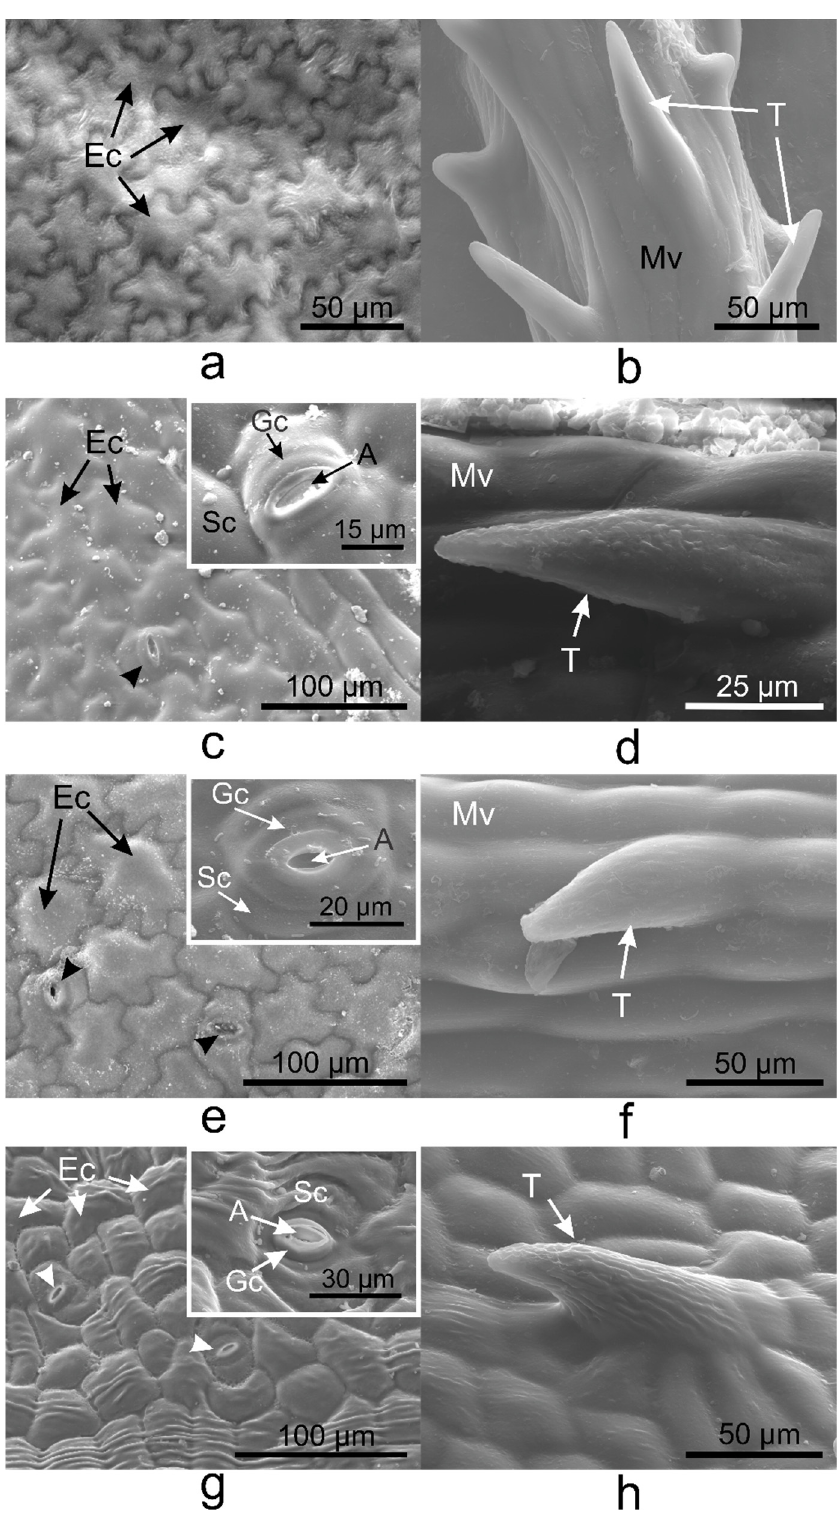
Figure 1. Scanning electron microscopy (SEM) micrographs showing the adaxial (upper) epidermis of the Vinca leaves with an overview of the differently shaped epidermal cells and insets with a detailed view of stomata, indicated by the arrowheads ( a , c , e , g ), and non-glandular trichomes observed on the midveins ( b , d , f ) and secondary veins ( h ). ( a , b ) V. minor , ( c , d ) V. major , ( e , f ) V. major var. variegata , ( g , h ) V. herbacea ; A—aperture, Ec—epidermal cell, Gc—guard cell, Mv—midvein, Sc—subsidiary cell, T—trichome.